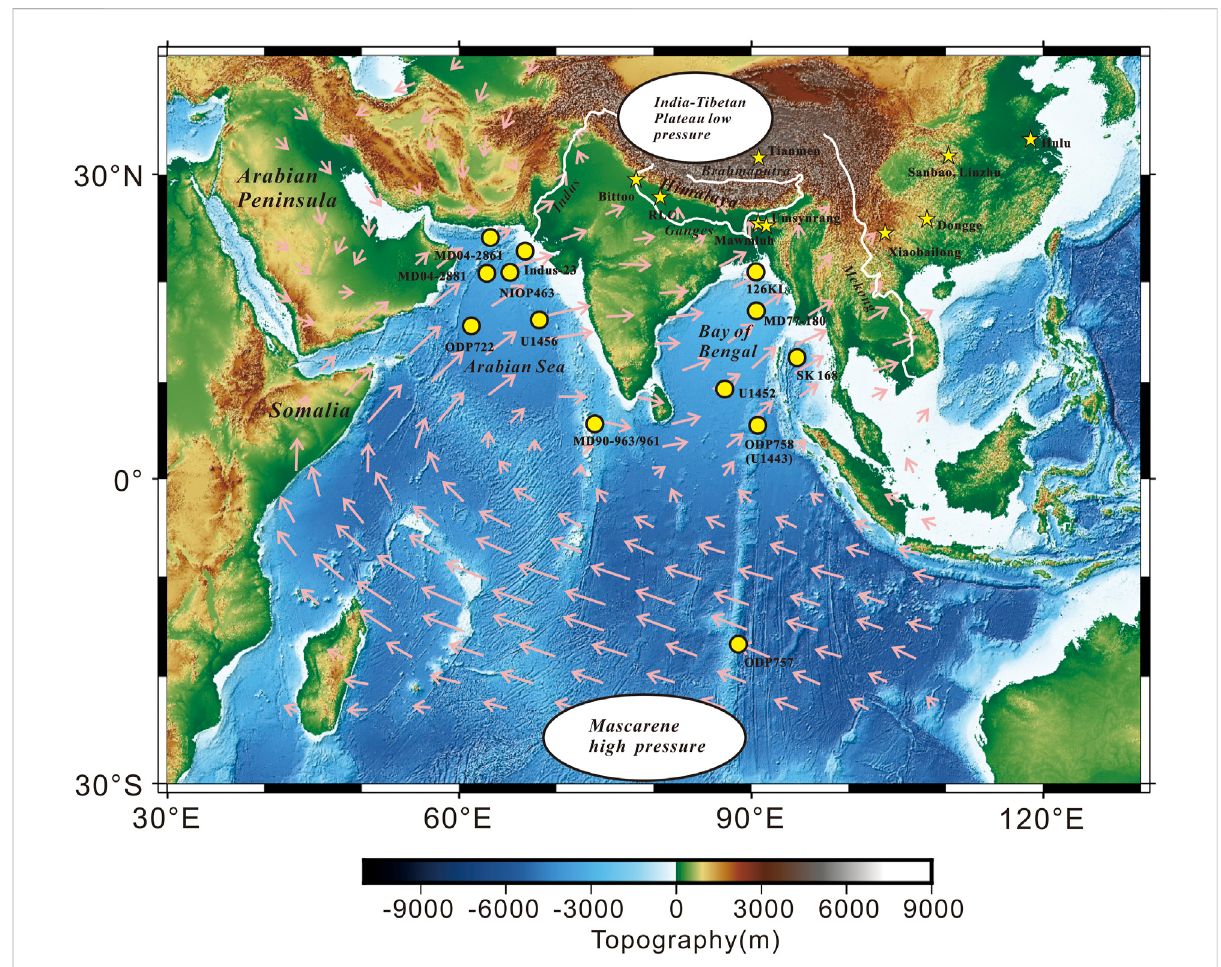
FIGURE 1 Location map showing marine sediment sites (yellow dots), terrestrial caves (yellow stars), and wind directions of the ISM (pink